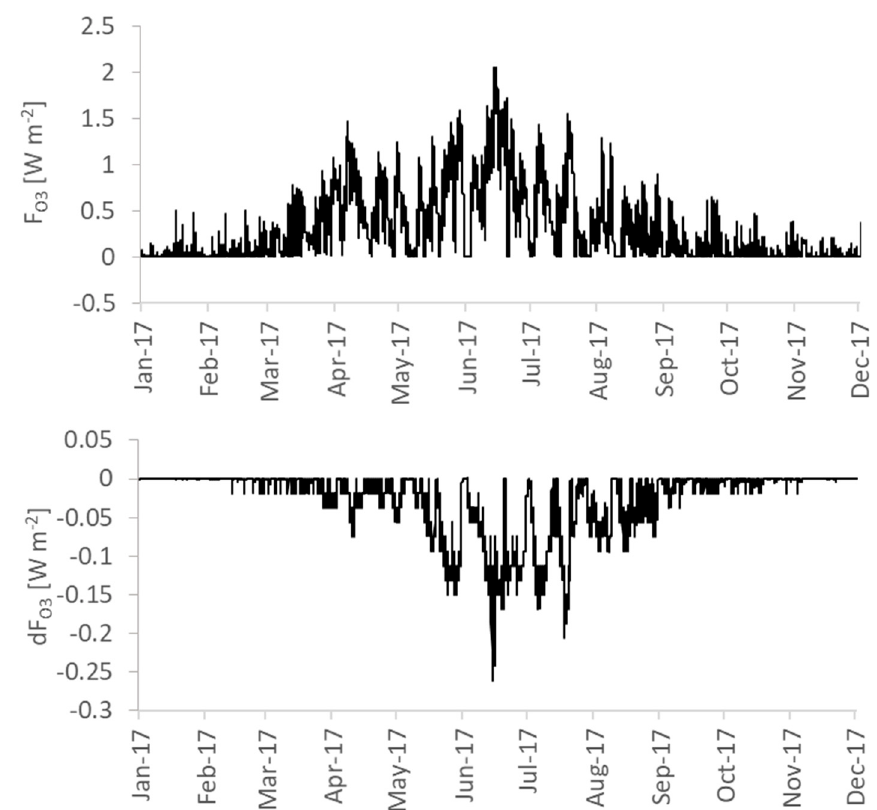
Figure 7. Calculated radiation e ff ect of tropospheric ozone with an annual mean of 0.28 W m − 2 for Figure 7: Calculated radiation effect of tropospheric ozone with an annual mean of 0.28 W m − 2 for Black Forest conditions. Upper panel: Pattern of the radiation e ff ect of O 3 ( F O3 ) during 2017; bottom Black Forest conditions. Upper panel: Pattern of the radiation effect of O 3 ( F O3 ) during 2017; bottom panel: Di ff erence between current composition and a 50% beech / fir mixture in W m − 2 panel: Difference between current composition and a 50% beech/fir mixture in W m − 2 .